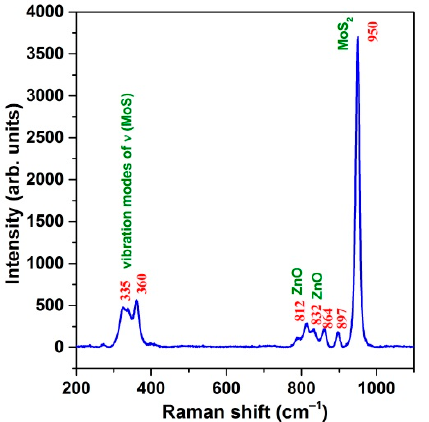
Figure 3. Raman spectrum of the prepared MoS 2 @ZnO nanoheterostructures.